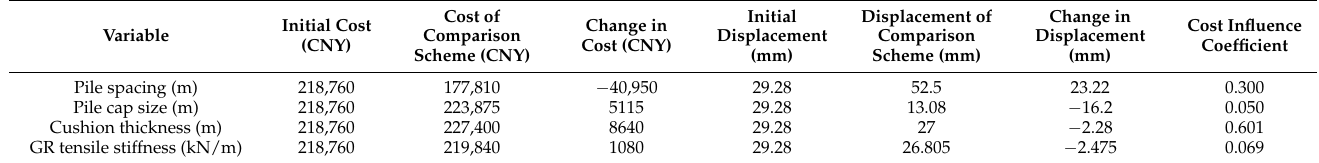
Table 7. Cost influence coefficient for each variable in scheme